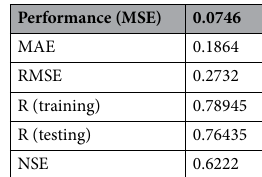
Table 8. Evaluation using LM